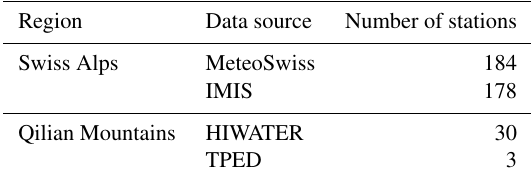
Table 1. Summary of observational stations